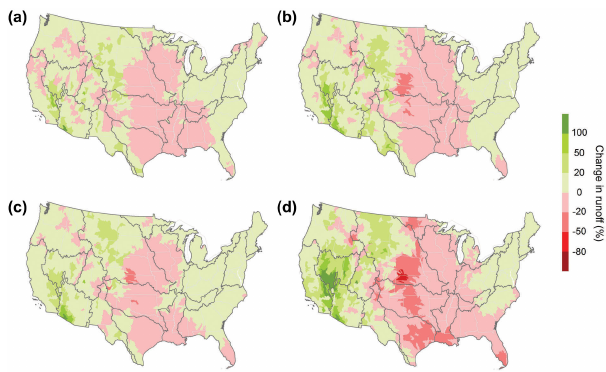
Figure 5. Projected changes in multi-year mean annual runoff (%) at HUC-8 watershed scale. (a–d) Changes from the base- line to S1 (RCP4.5/2030s) (a) , S2 (RCP4.5/2080s) (b) , S3 (RCP8.5/2030s) (c) , and S4 (RCP8.5/2080s) (d) scenarios. The maps display the multi-model mean changes from the 20